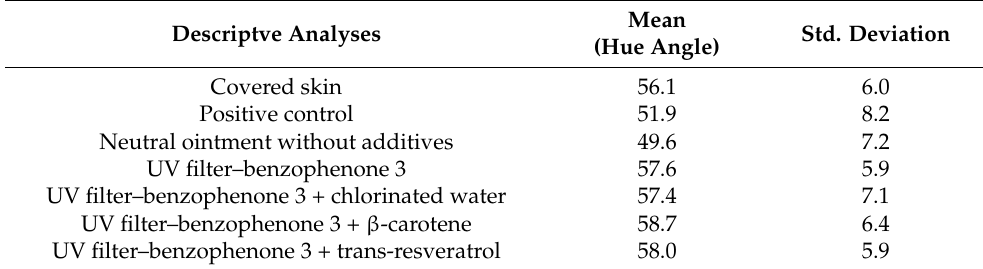
Table 3. The descriptive statistics of the main features of skin color after 8 min UV irradiation (N = 26